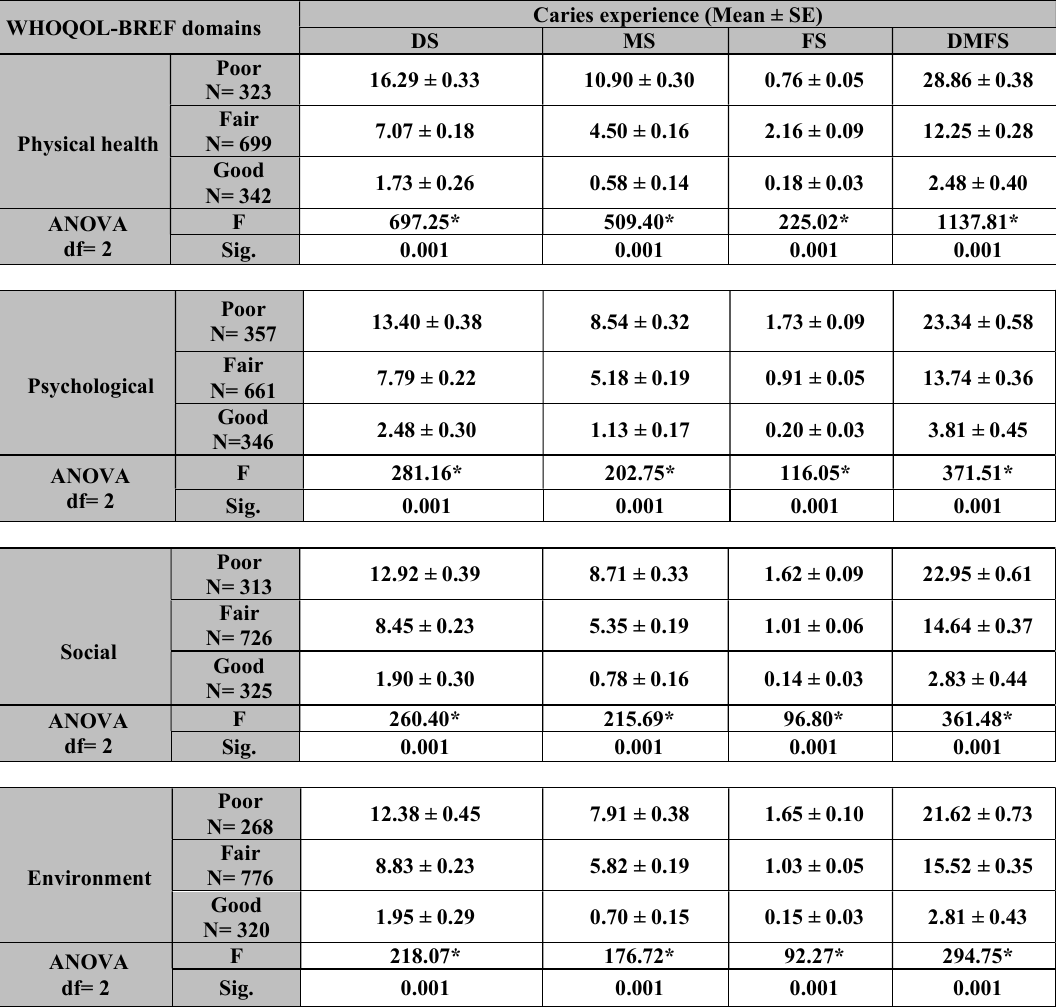
Table (3): Caries Experience DMFS and its Components (DS, MS, FS) according to Quality of Life Domains Scores.